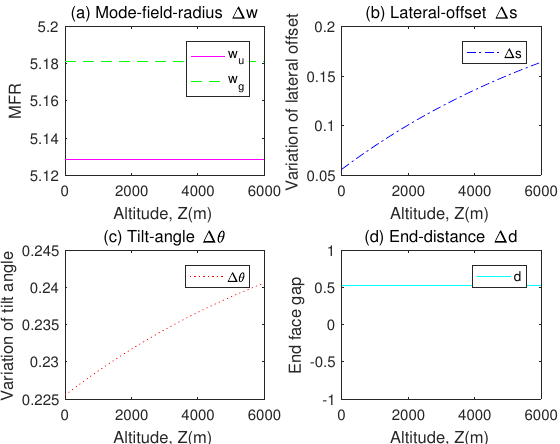
Figure 5. Fusion variables versus altitudes, the abscissa represents the altitude and increases in steps size of 10 m, and the ordinate represents four fusion variables affected by the high altitude environment. ( a ): the mode field radii of G.652.D and ULL fibers are w g and w u ( µ m) respectively, and variation ∆ w is 0; ( b ):variation of lateral offset ∆ s ( µ m); ( c ):variation of tilt angle ∆ θ (degrees); ( d ): the end face spacing of two optical fibers, and variation ∆ d ( µ m) is